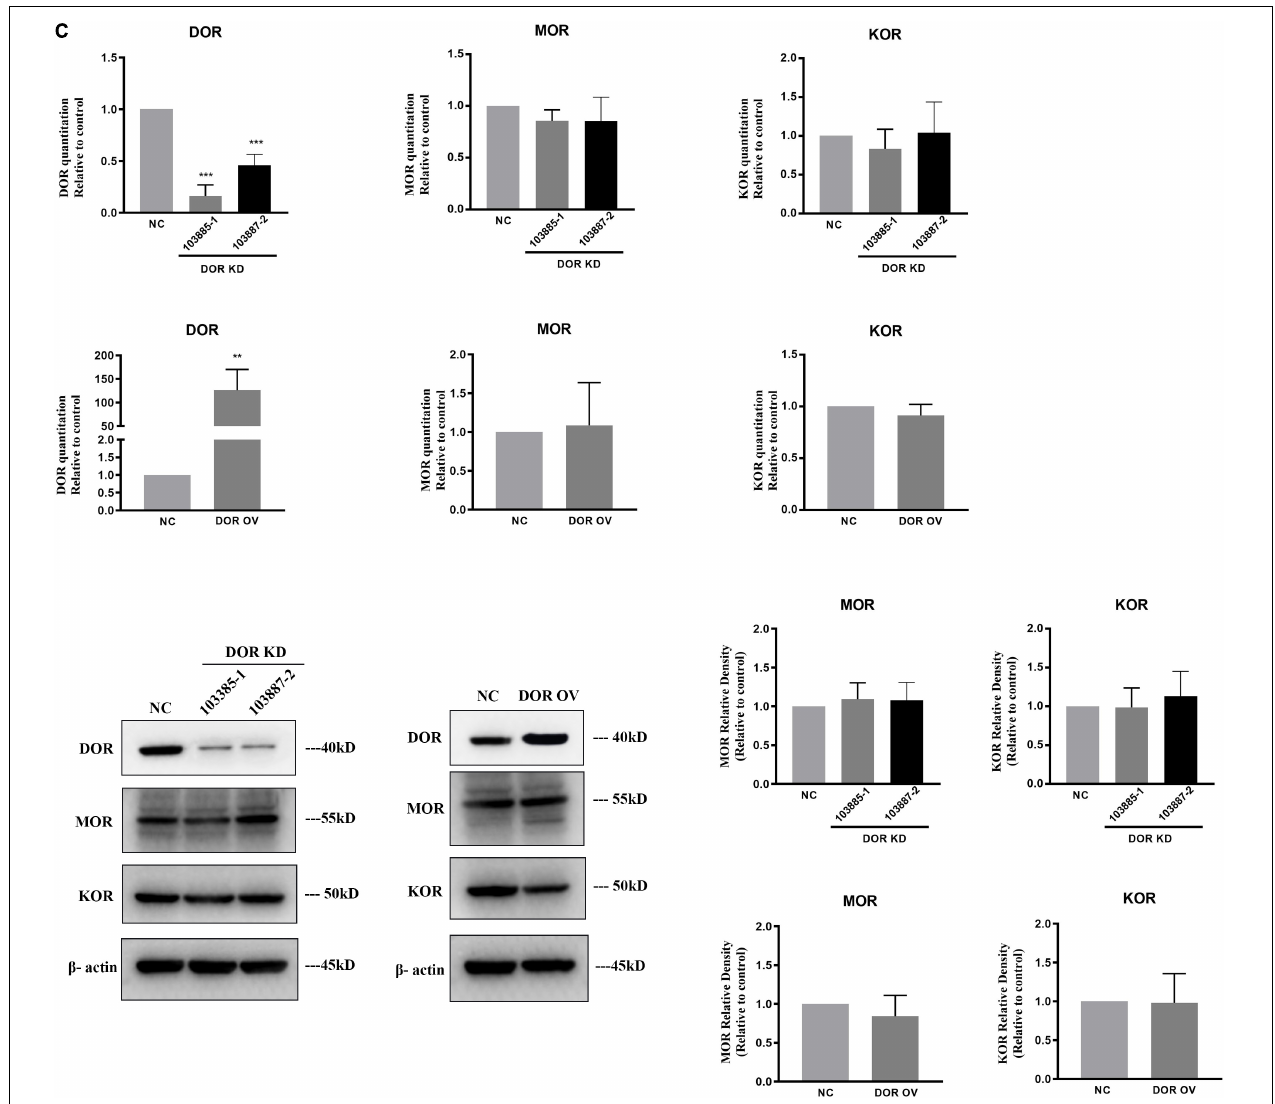
FIGURE 4 | A critical role of δ -opioid receptor (DOR) for anti-microglial activation. NC, negative control; DOR KD, DOR knockdown; DOR OV, DOR overexpression. (A) RT-PCR evaluation of the efficiency of plasmids infection. * p < 0.05, *** p < 0.001, **** p < 0.0001 vs. NC. Note that the DOR knockdown shRNA plasmids infections significantly reduced DOR mRNA expression in BV2 cells, especially the 103885-1 and 103887-2. The BV2 cells infected with 71788-1 plasmids showed folds increases in DOR mRNA compared to the negative control. (B) DOR knockdown or overexpression-induced alterations in MHCII and arginase protein expression. ** p < 0.01, *** p < 0.001 vs. NC. Note that DOR knockdown caused an upregulation of both MHCII and arginase, while DOR overexpression did not seriously affect MHCII and arginase expression. (C) Effects of DOR knockdown or overexpression on MOR and KOR of BV2 cells. ** p < 0.01, *** p < 0.001 vs. NC. Note that 103885-1 and 103887-2, the DOR knockdown shRNA plasmids significantly reduced DOR mRNA expression in BV2 cells. The BV2 cells infected with 71788-1 plasmids showed folds increases in DOR mRNA compared to the negative control. Neither DOR knockdown nor overexpression caused any appreciable change in MOR and DOR expression by RT-PCR or Western blot